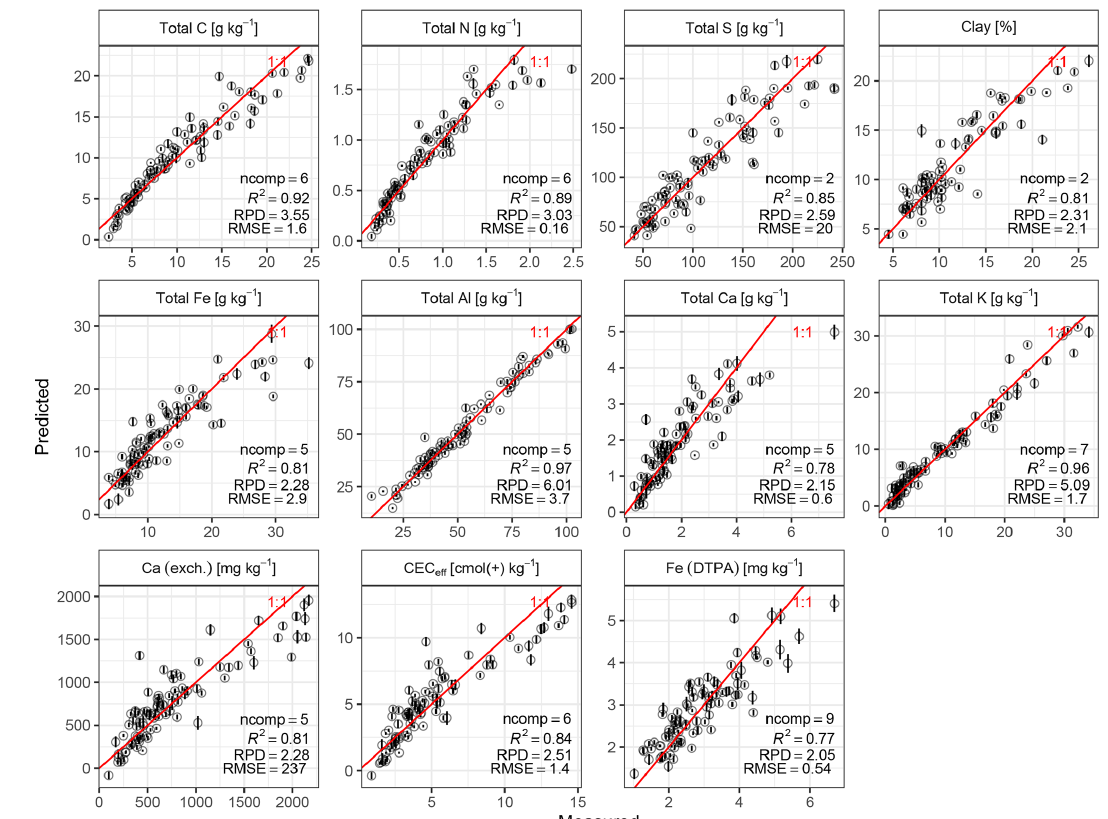
Figure 3. Cross-validated predictions of soil properties derived from best mid-infrared (mid-IR) partial least squares regression (PLSR) models vs. laboratory reference measurements (see Fig. 1). Average estimates, their confidence intervals (error bars), and evaluation metrics were derived with 10-fold cross-validation repeated five times. “ncomp” is the number of PLSR components of most accurate final models, RSME is the root mean square error, and RPD is the ratio of performance to deviation. Only soil properties modeled with R 2 > 0 . 75 are shown. CEC eff is the effective cation exchange capacity. Exchangeable (exch.) elements were determined with BaCl 2 . Bioavailable Fe was determined via diethylenetriaminepentaacetic acid (DTPA)